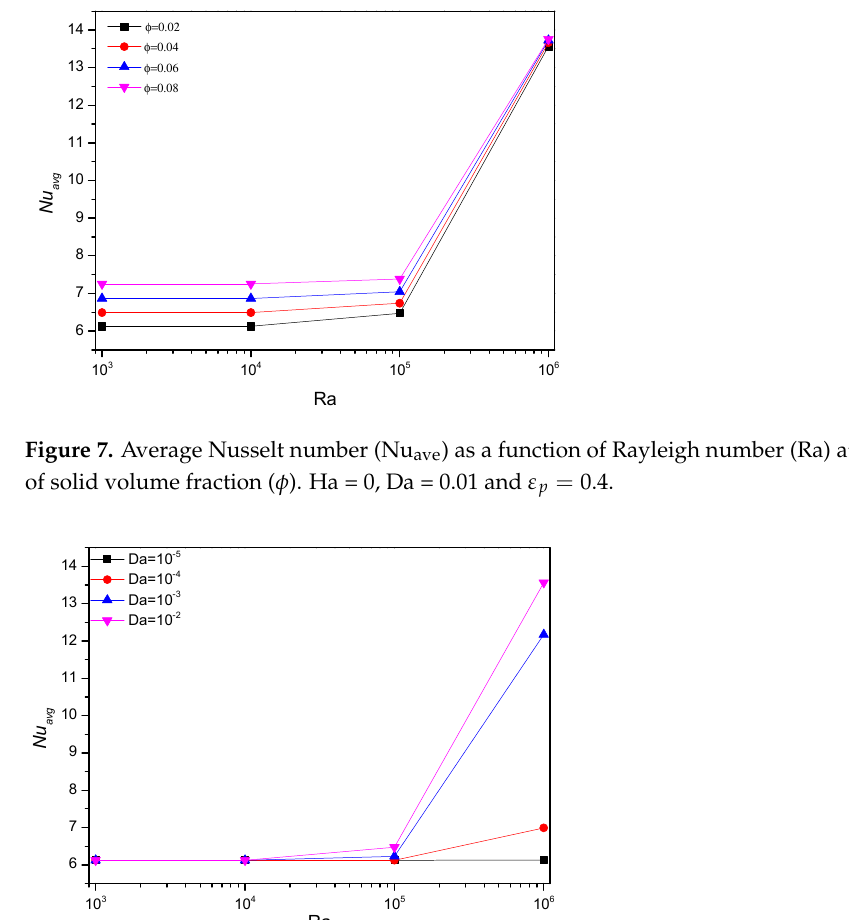
Figure 6. Average Nusselt number (Nu ave ) as a function of Rayleigh number (Ra) at various values ) . Η a = 0, Da = 0,01 and 𝜙 = 0.02. of porosity ( 𝜀 (cid:3043)